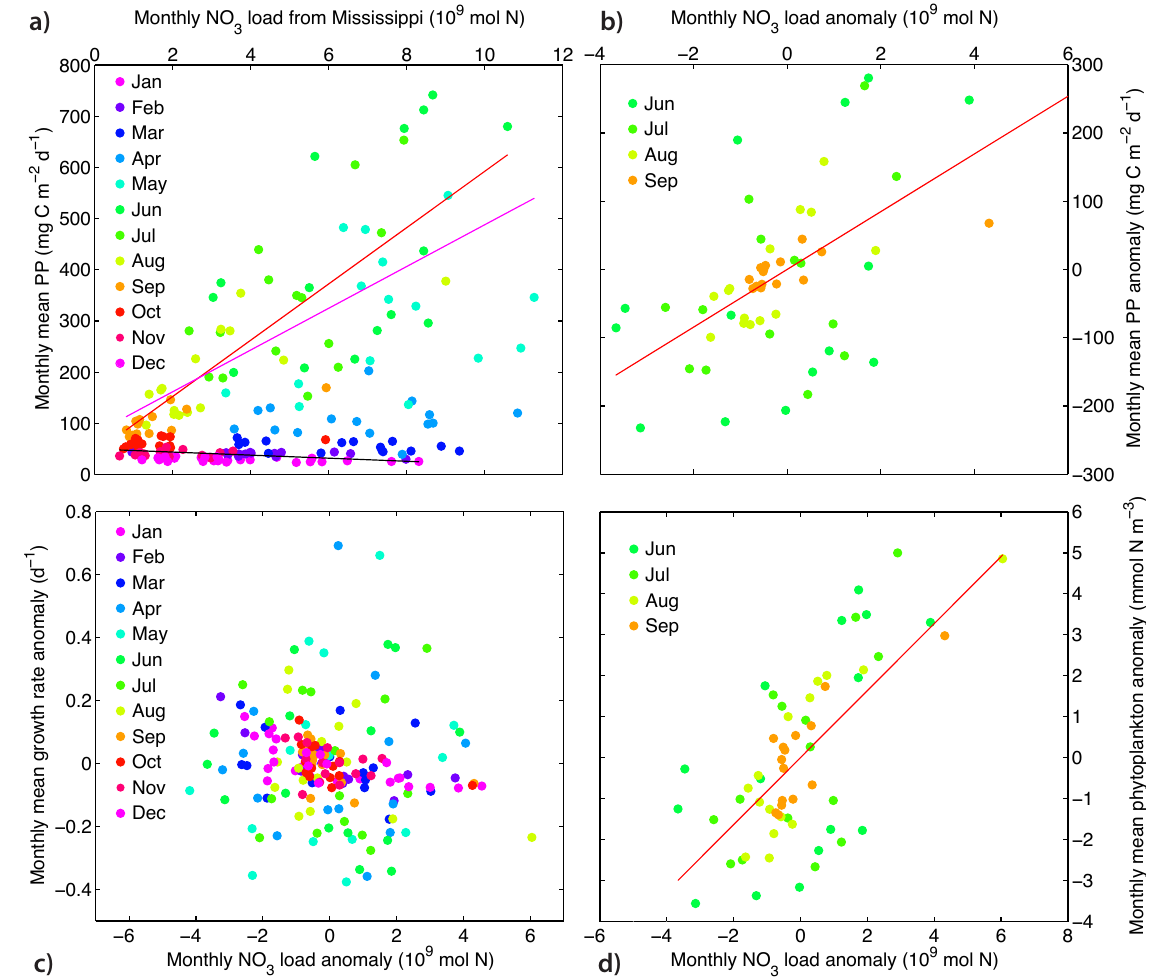
Fig. 15. Simulated monthly mean variables for the delta region plotted over monthly NO 3 load from the Mississippi River for the simulation period from January 1990 to December 2004. (a) Primary production over NO 3 load (colored dots) and their linear regressions (solid lines) for June through September (red), May through September (magenta) and October through February (black). (b) Anomaly of primary production over anomaly of NO 3 load for June through September (colored dots) and their linear regression (red line). (c) Anomaly of phytoplankton growth rate over anomaly NO 3 load. (d) Anomaly of phytoplankton biomass over anomaly of NO 3 load (colored dots) and their linear regression (red line). Regression parameters are given in Table